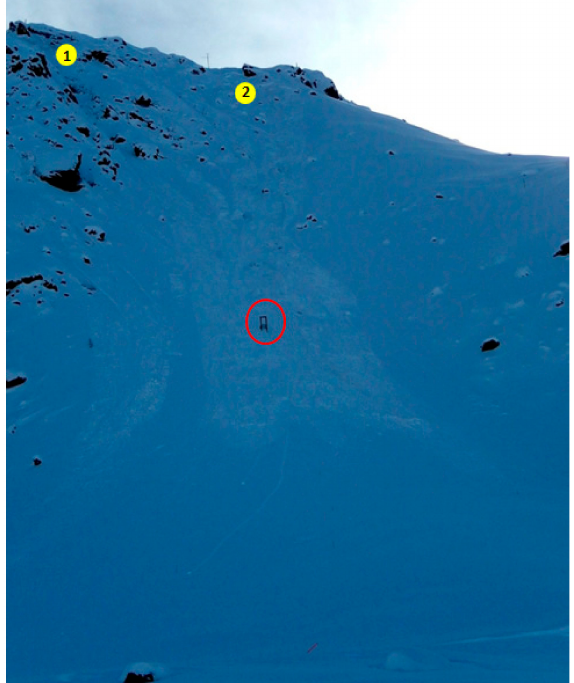
Figure 10. Overview of the 20 January 2014 avalanche. The yellow dots indicate the two triggering points and the red circle the obstacle. Photo L.